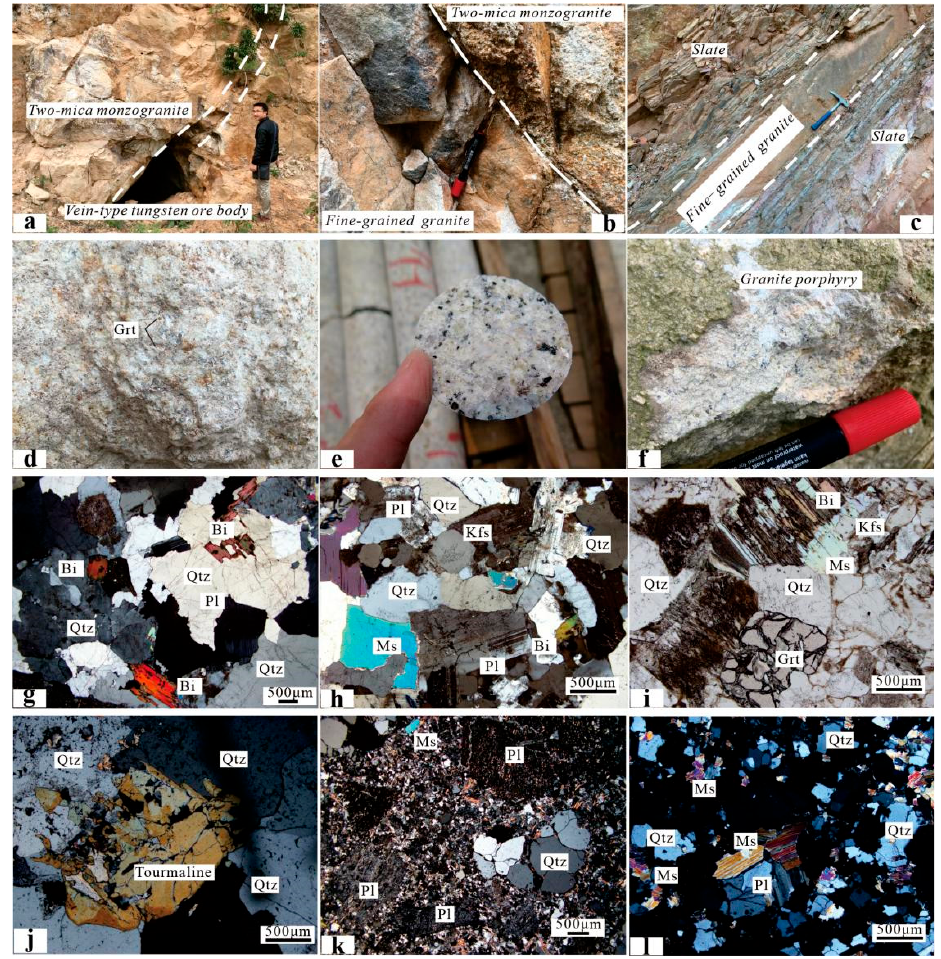
Figure 4. Petrographic photographs of intrutions in Chuankou ore field. ( a ) the wolframite- quartz vein in coarse two-mica monzogranite(G-2), ( b ) Fine-grained granite (G-3) intrude into coarse two-mica monzogranite, ( c ) Fine-grained granite (G-3) intrude into shallow metamorphic slate, ( d ) Disseminated spessartine developed in two-mica monzogranite(G-3), ( e , g ) Biotite monzogranite(G-1), ( f , k ) Granite porphyry(G-4), ( h – j ) Two-mica monzogranite(G-2), ( l ) Fine-grained granite(G-3). Bi- biotite, Pl- plagioclase, Kfs- K-feldspar, Ms- muscovite, Qtz- quartz, Grt- garnet.